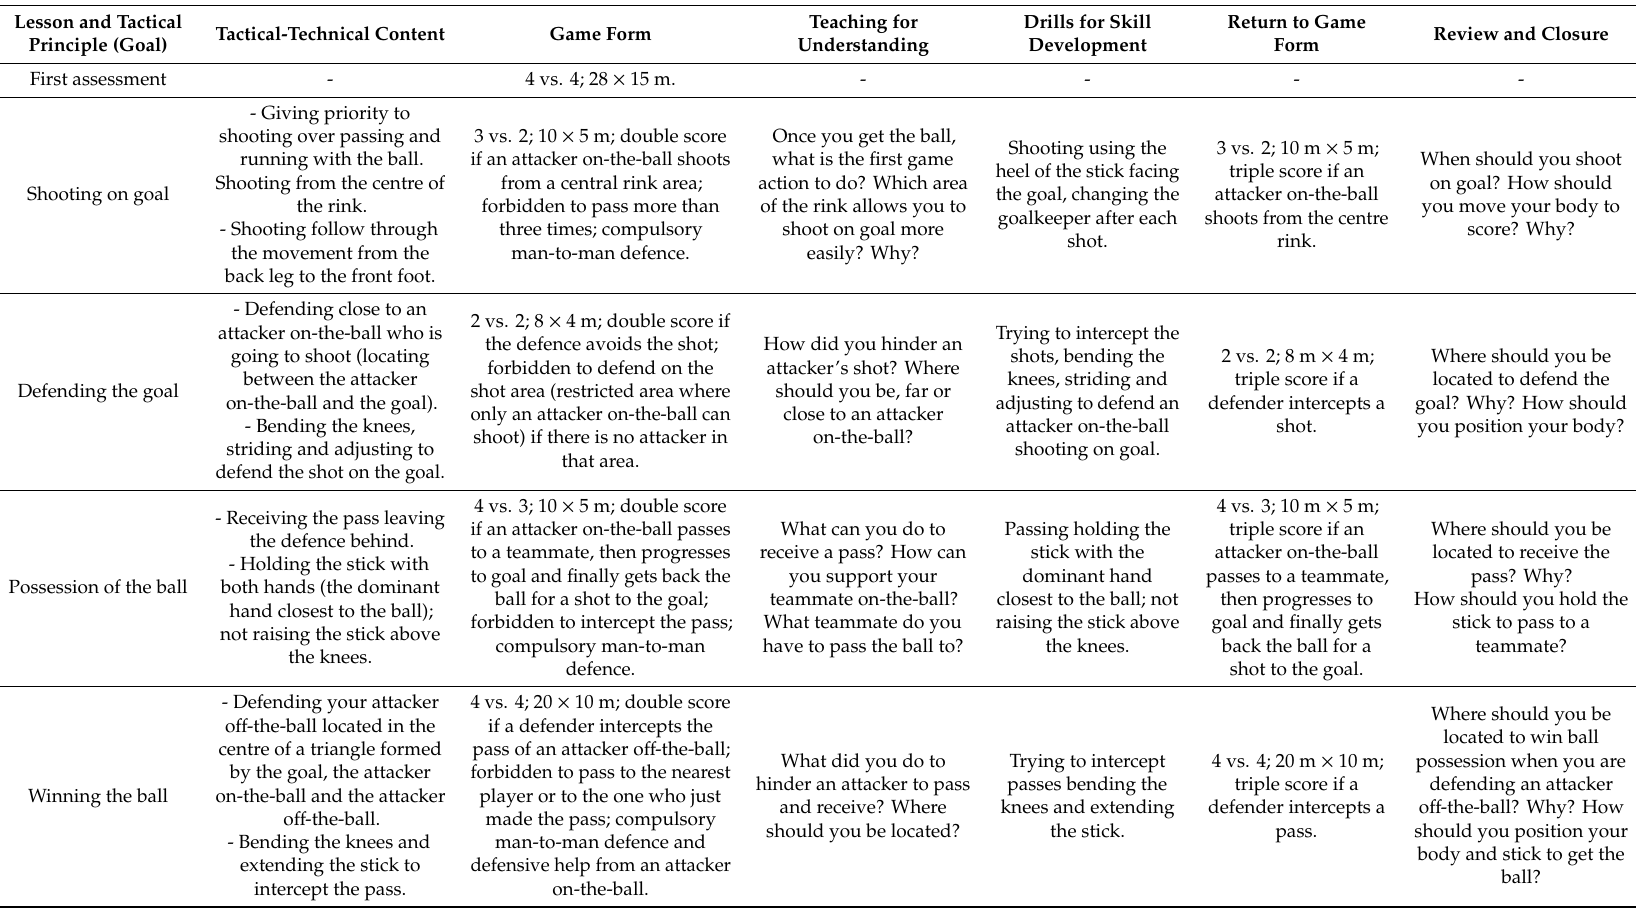
Table 1. Features of the Teaching Games for Understanding